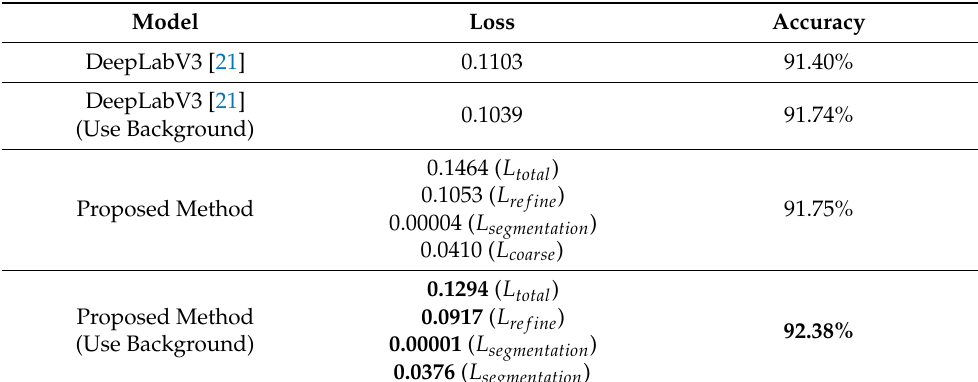
Table 3. Training results of each model.